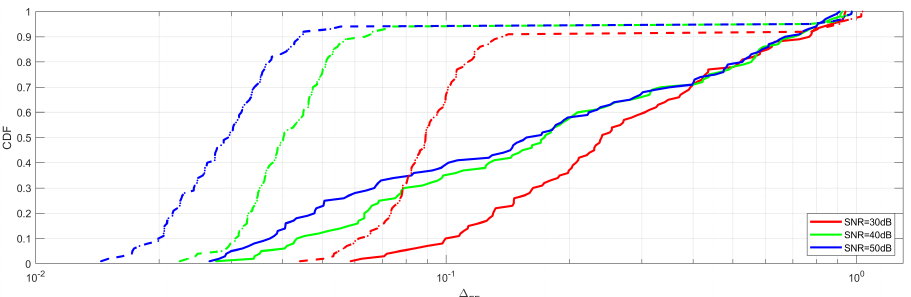
Figure 9. Cumulative density function of the reconstruction error for the random sets of S = 5 sparse sources in the Ξ region for a variable SNR. Solid lines: “standard” approach; dashed lines: “smooth”